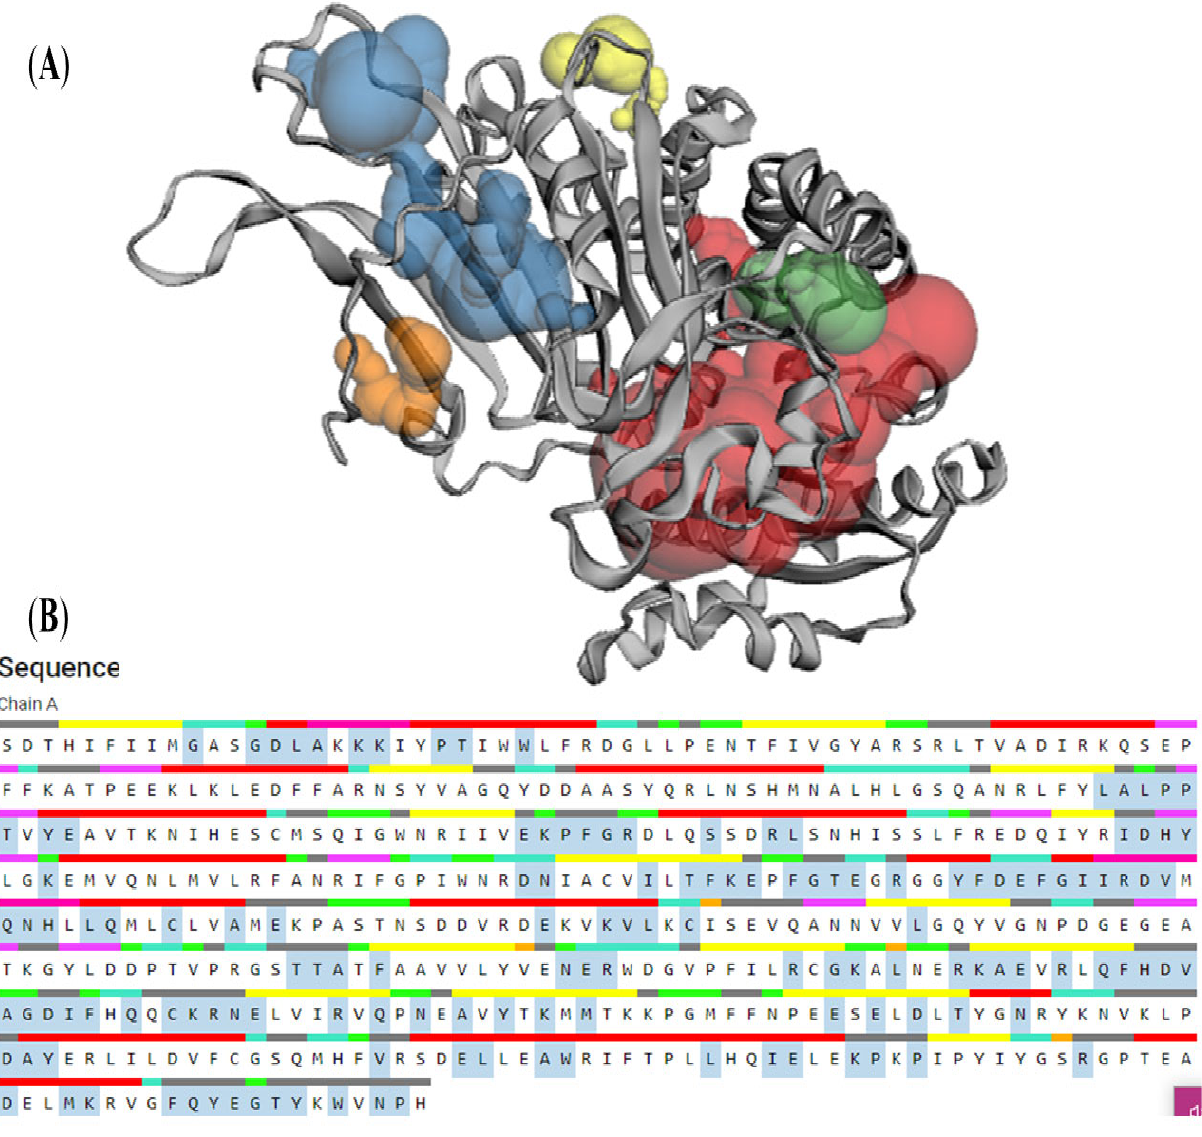
Figure 10. CASTp analysis. ( A ) Pocket panel and ( B ) Sequence panel. Table 6. Topological feature analysis by